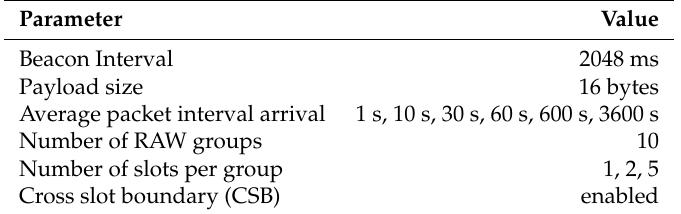
Table 8. Configuration for the evaluation of restricted access window (RAW) energy